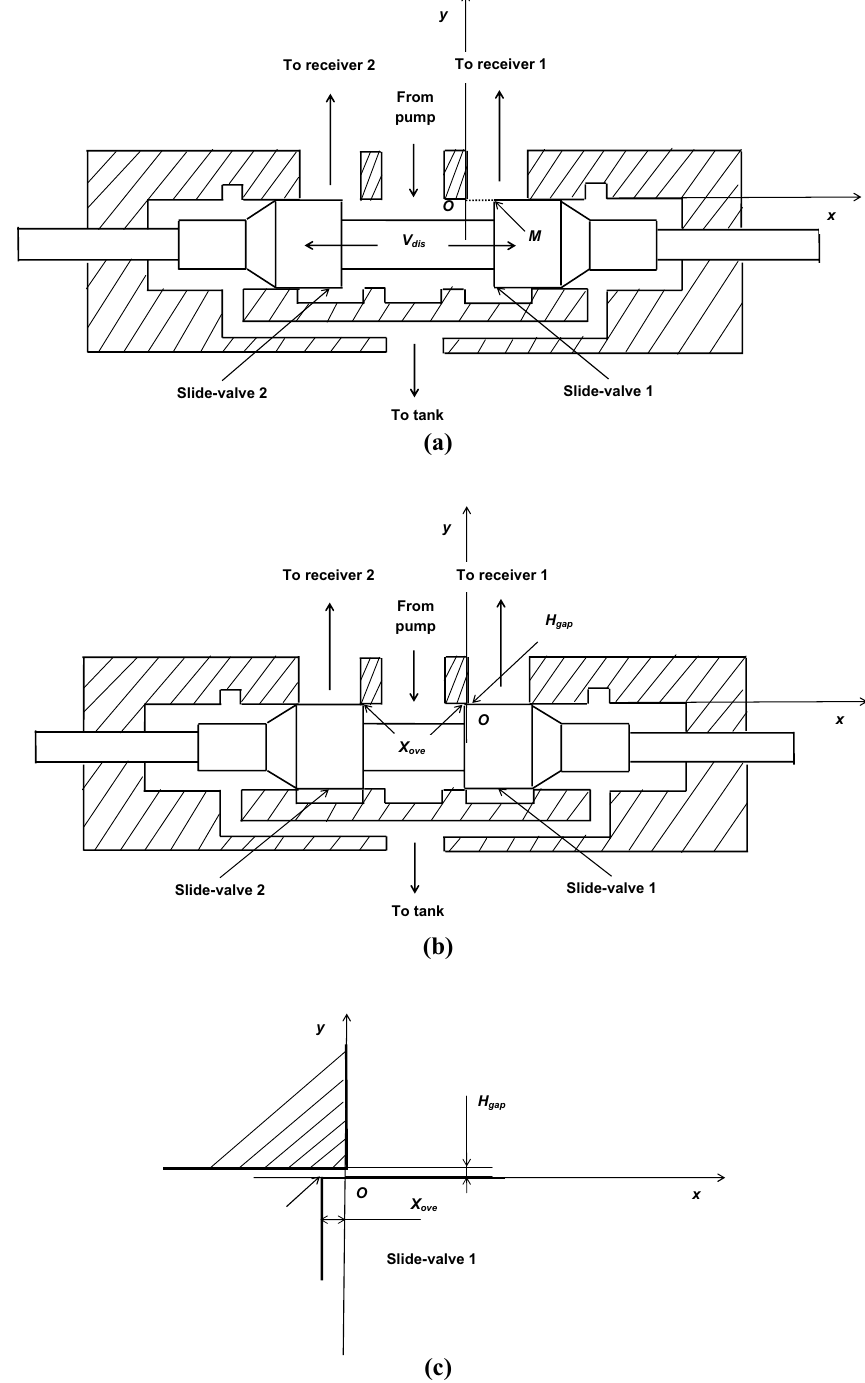
Fig. 1 Scheme of the slide- valve system a distributor opened, b distributor closed, c zoom at the overlap in case